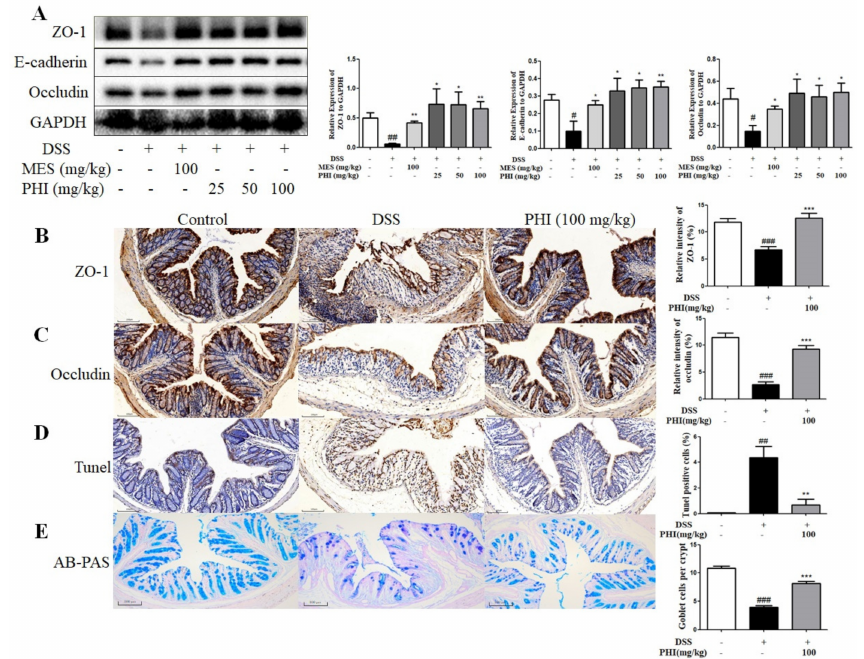
Figure 4. PHI treatment improved the intestinal mucosa barrier of colitis colon tissues. ( A ) Protein levels of ZO-1, E-cadherin, and occludin in colons were detected by Western blotting. ( B , C ) Immuno- histochemical staining of ZO-1 and occludin (scale bar = 100 µ m). ( D ) Apoptosis of colon tissues were subjected to TUNEL staining (scale bar = 100 µ m). ( E ) Goblet cells were detected by AB-PAS staining (scale bar = 100 µ m). # p < 0.05, ## p < 0.01, and ### p < 0.001 vs. control group. * p < 0.05,